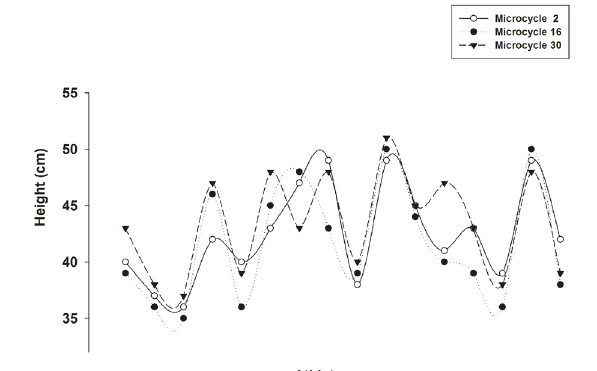
Fig. 2 Height of countermovement vertical jump (CMVJ) performed by each basketball player during different moments of the training